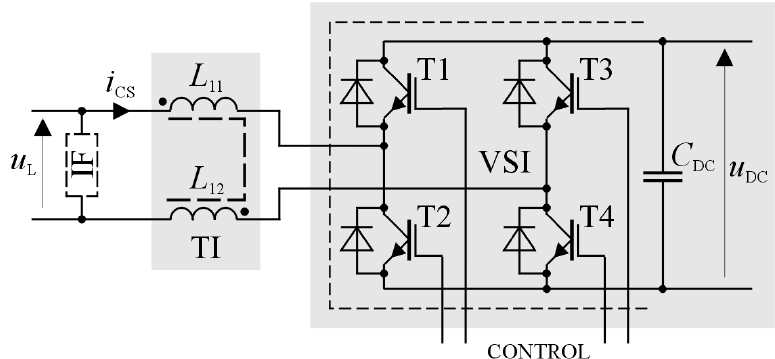
Figure 2. Diagram of the power stage of the PSP, associated with the VCCS.